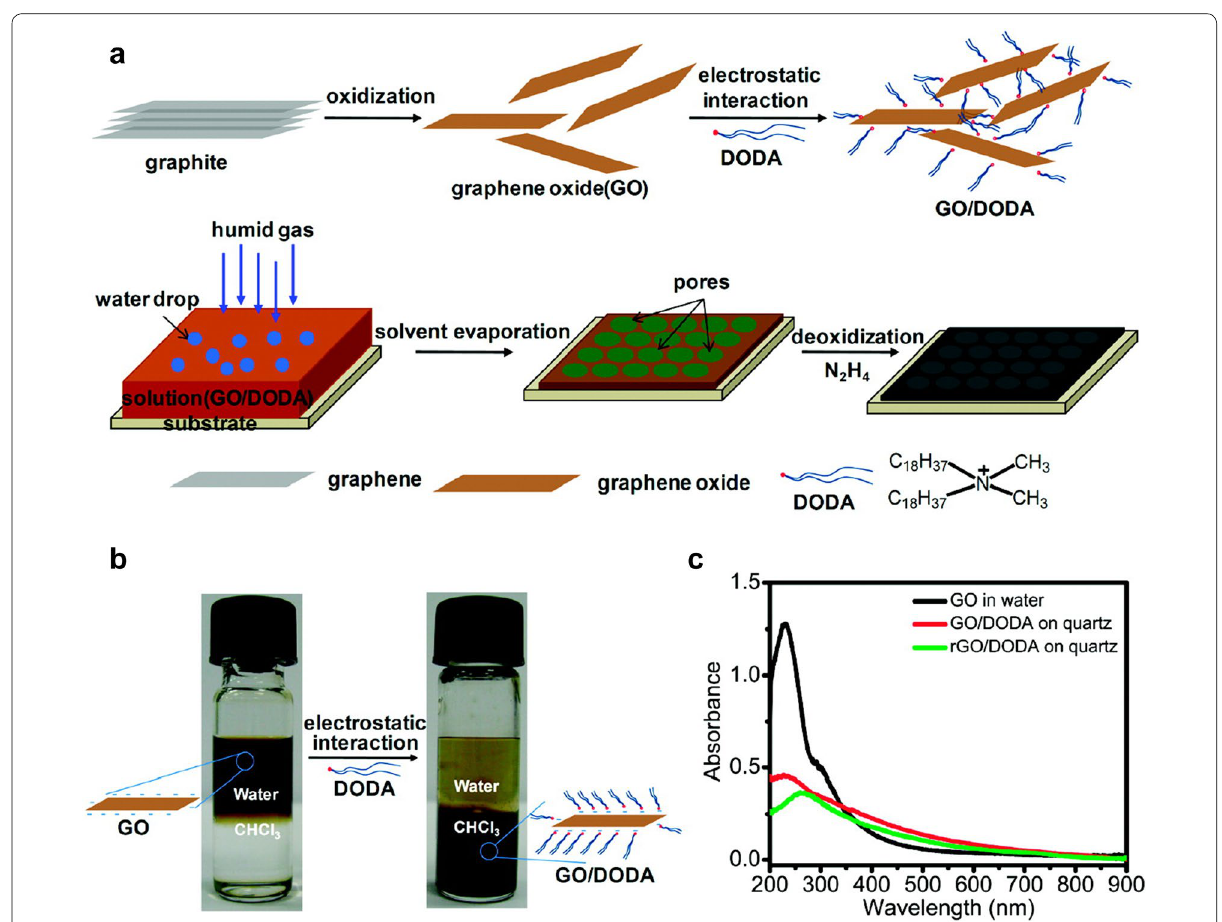
Fig. 3 Processes to form honeycomb structures composed of graphene sheets: a schematic drawing of the preparation of the honeycomb struc‑ tured film based on graphene oxide; b photographs of the GO solution during phase transfer process by DODA; c the UVvis spectra of the GO in water (black), GO/DODA casting film (red), and the rGO/DODA film after exposure to N2H4 vapor (green) (Reprinted with permission